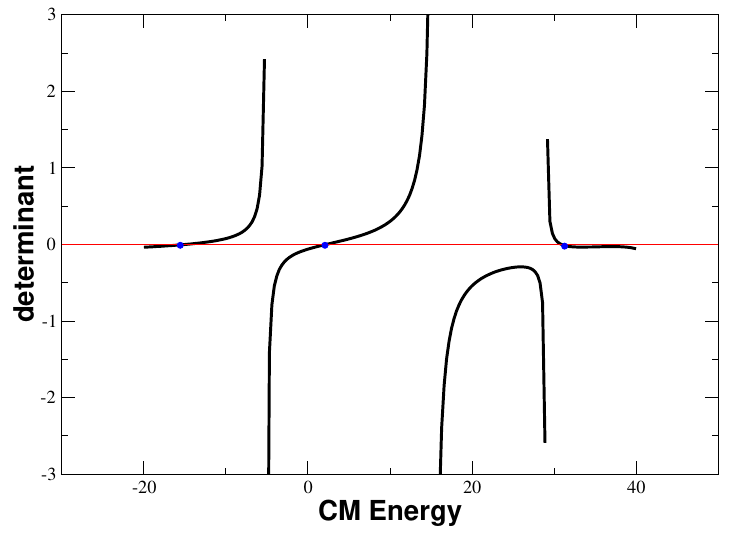
Figure 5 . The determinant from eq. (3.21). The values of the parameters are (cid:3) a = 225 L=a = 1, while the shaded blobs correspond to the position of the energy